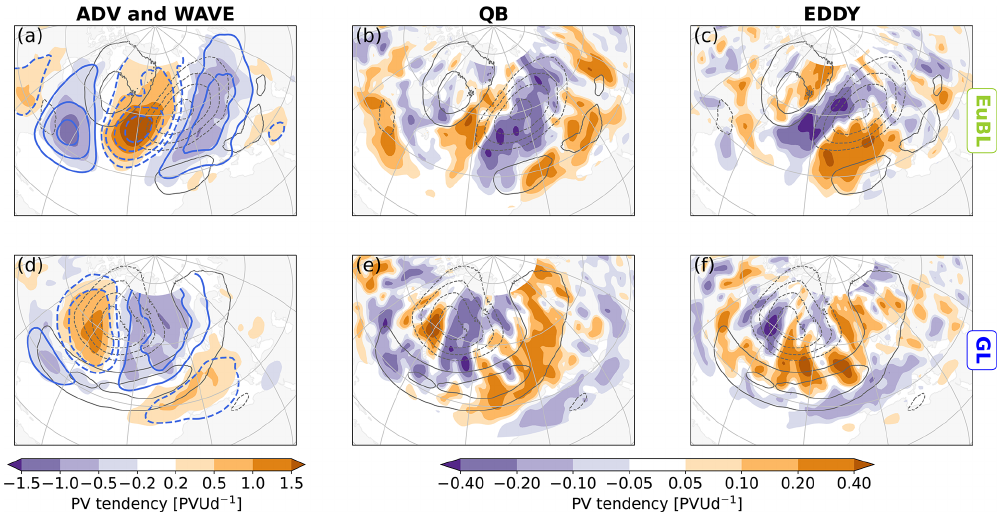
Figure 5. PV tendencies averaged over 1–3d after onset smoothed by a 1–2–1 smoother for visual clarity. (a, d) Advection by the background flow (shading) and intrinsic wave propagation (blue contours, same values as color bar, negative values dashed). (b, e) Quasi-barotropic dynamics, i.e., the sum of the tendencies in the left column. Note the different color bar. (c, f) Convergence of the PV eddy flux. Panels (a–c) for EuBL, panels (d–f) for GL. Black contours depict the respective regime PV pattern, every 0.2PVU, negative values dashed, zero line